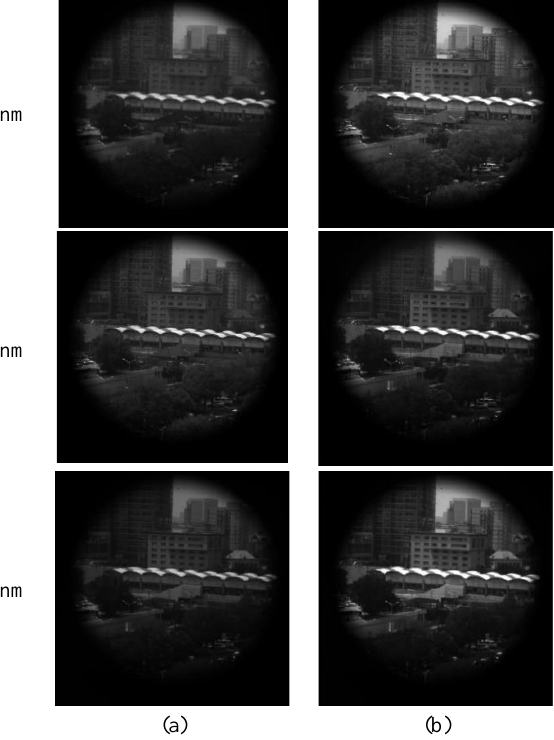
Fig. 5 dehazed results using three spectral bands. (a) the first image of four different original polarimetric images, (b) dehazed